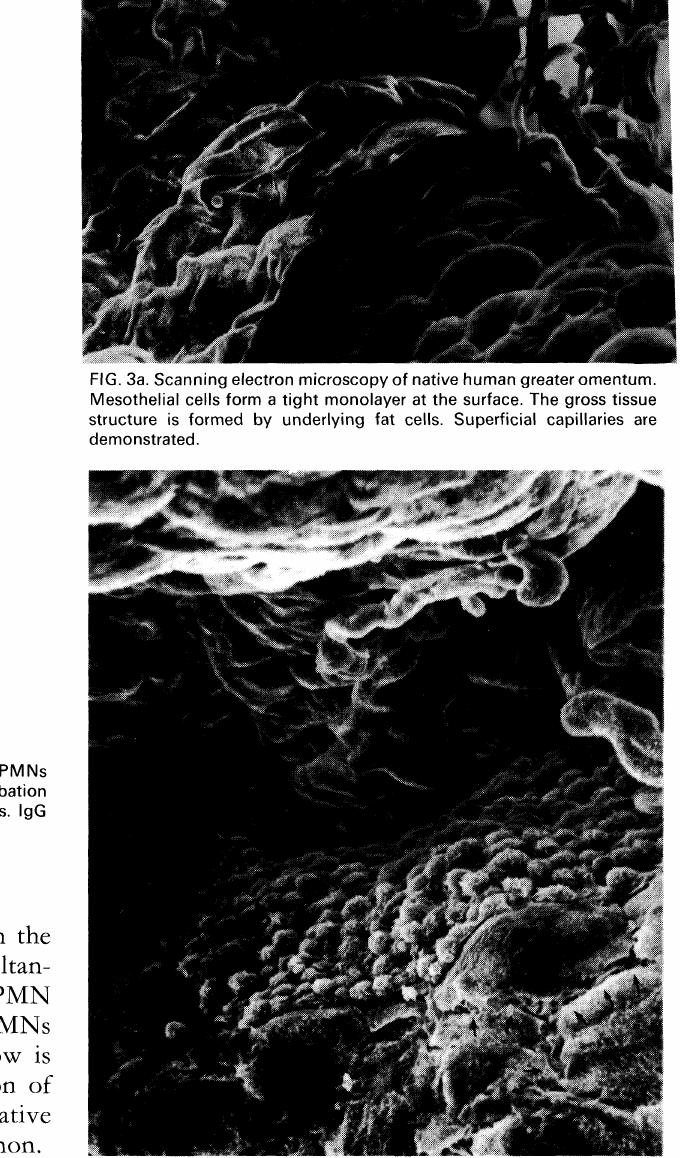
FIG. 3b. 90s after ZAP exposure. Retraction and disconnection of mesothelial cells in the near environment of activated leucocytes are visible as arrowed. The leucocytes themselves appeared at the tissue surface by their own chemotactic locomotion.